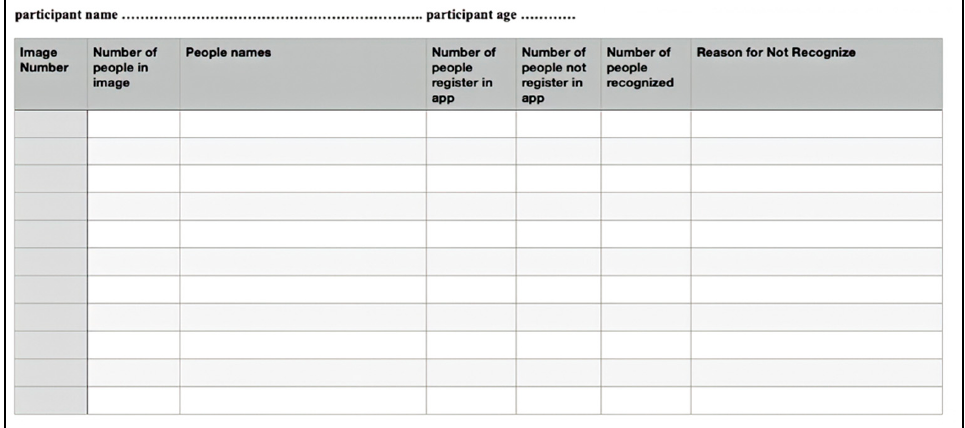
Figure 8. Tracking table for experience participants.